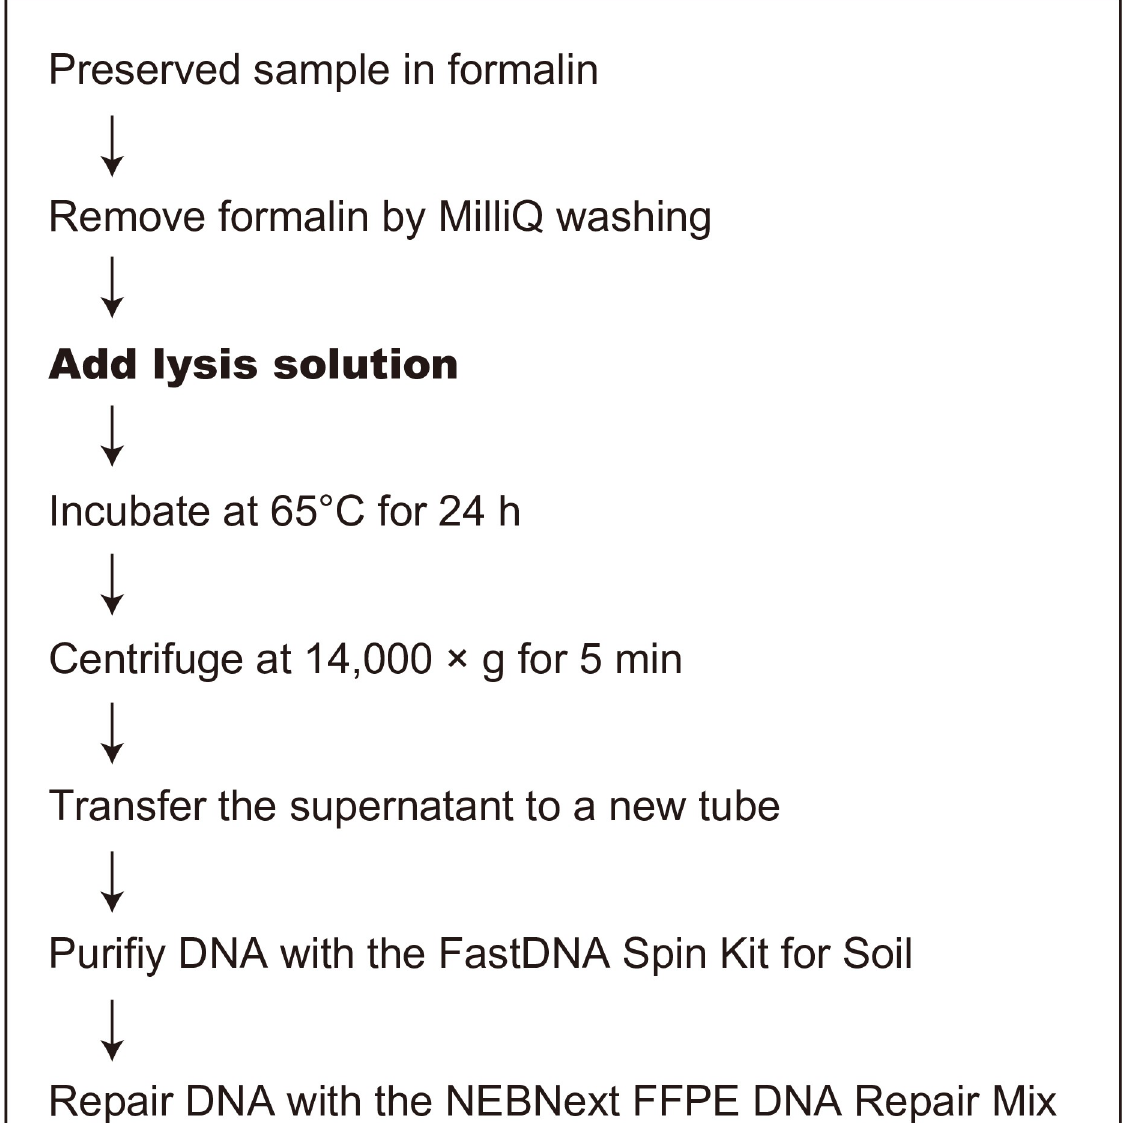
Fig 1. Procedure for extracting DNA from a sample preserved in formalin. Nine lysis solutions (see Table 2) were tested in this study (step shown in bold type).